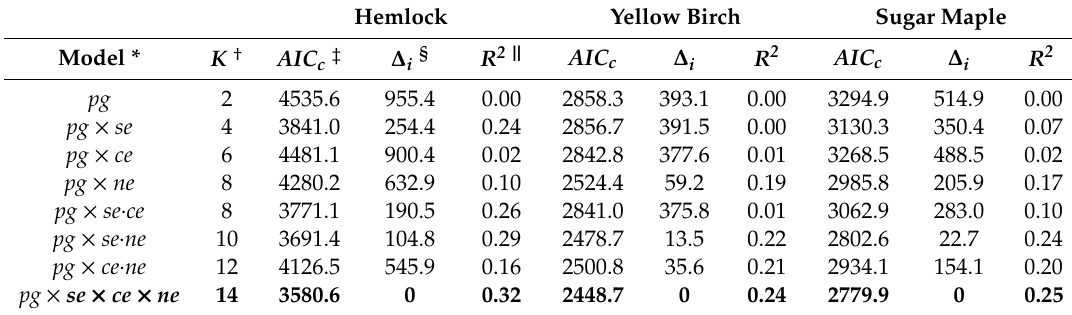
Table 3. Statistics for models of radial growth of three northern hardwood tree species in an old- growth hemlock forest in east–central New York, USA; the best model for each species (in bold) incorporates neighborhood competition, target tree size, and climate. Hemlock Yellow Birch Sugar Maple